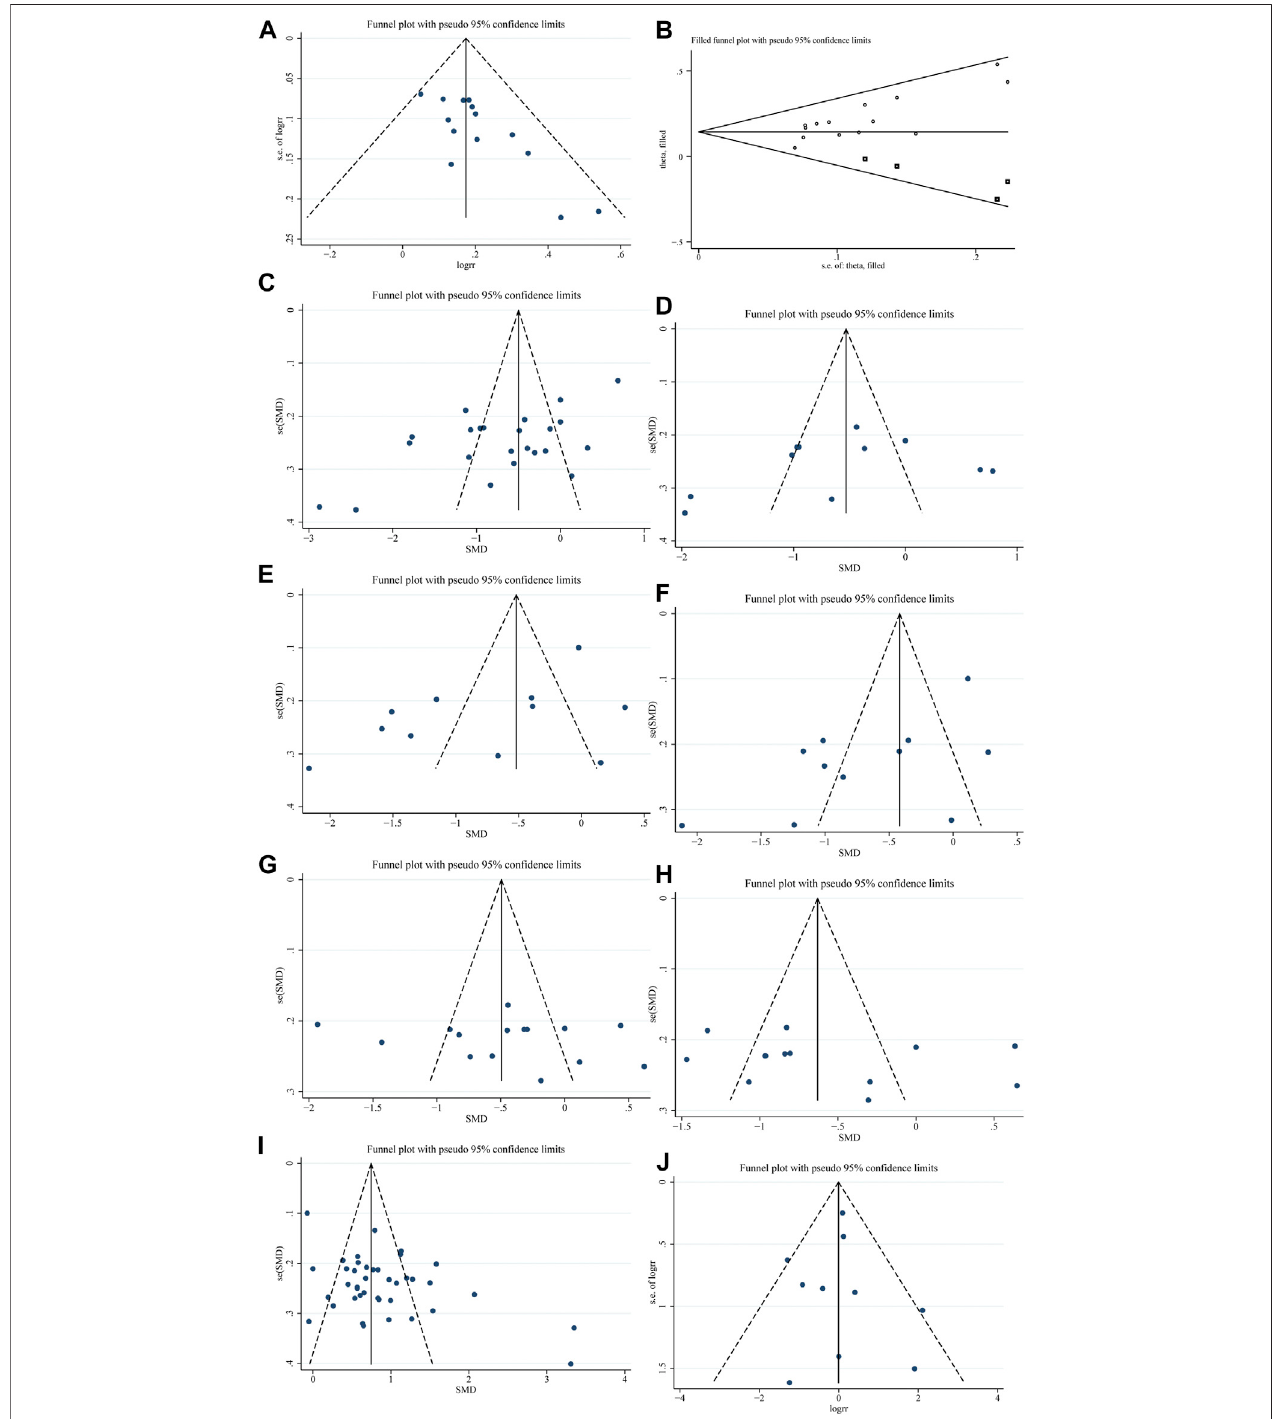
FIGURE 3| Funnel plots. (A) . Effectiveness. (B) . Effectiveness after trim. (C) . LVEDD. (D) . LVESD. (E) . LVEDVi. (F) . LVESVi. (G) . LVEDV. (H) . LVESV. (I) . LVEF. (J) . Other adverse